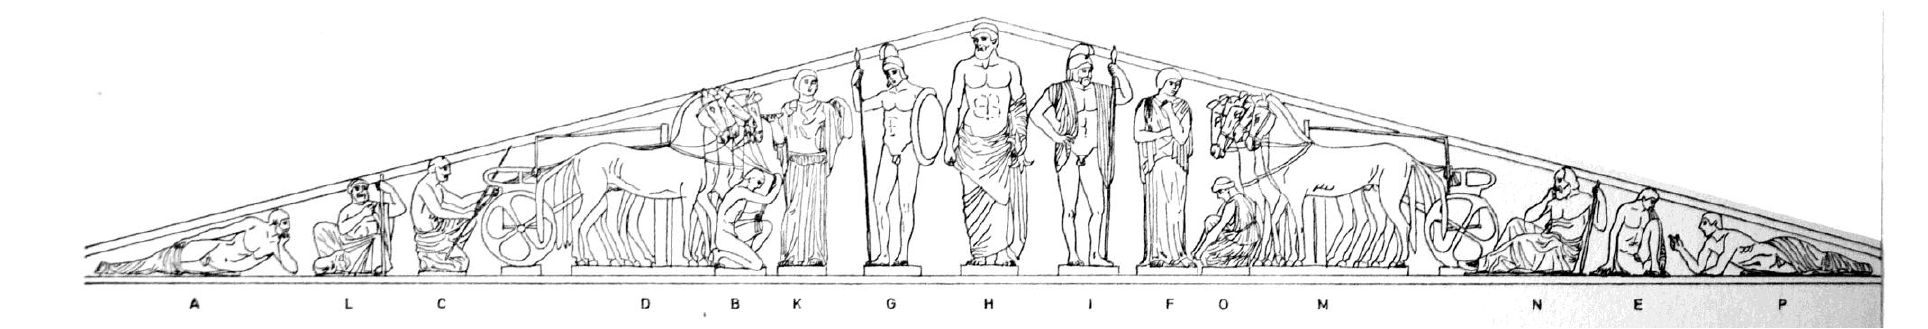
Figure 3. The most commonly accepted reconstruction (open arrangement "A") of the pediment (after Herrmann 1972 fig. 95)